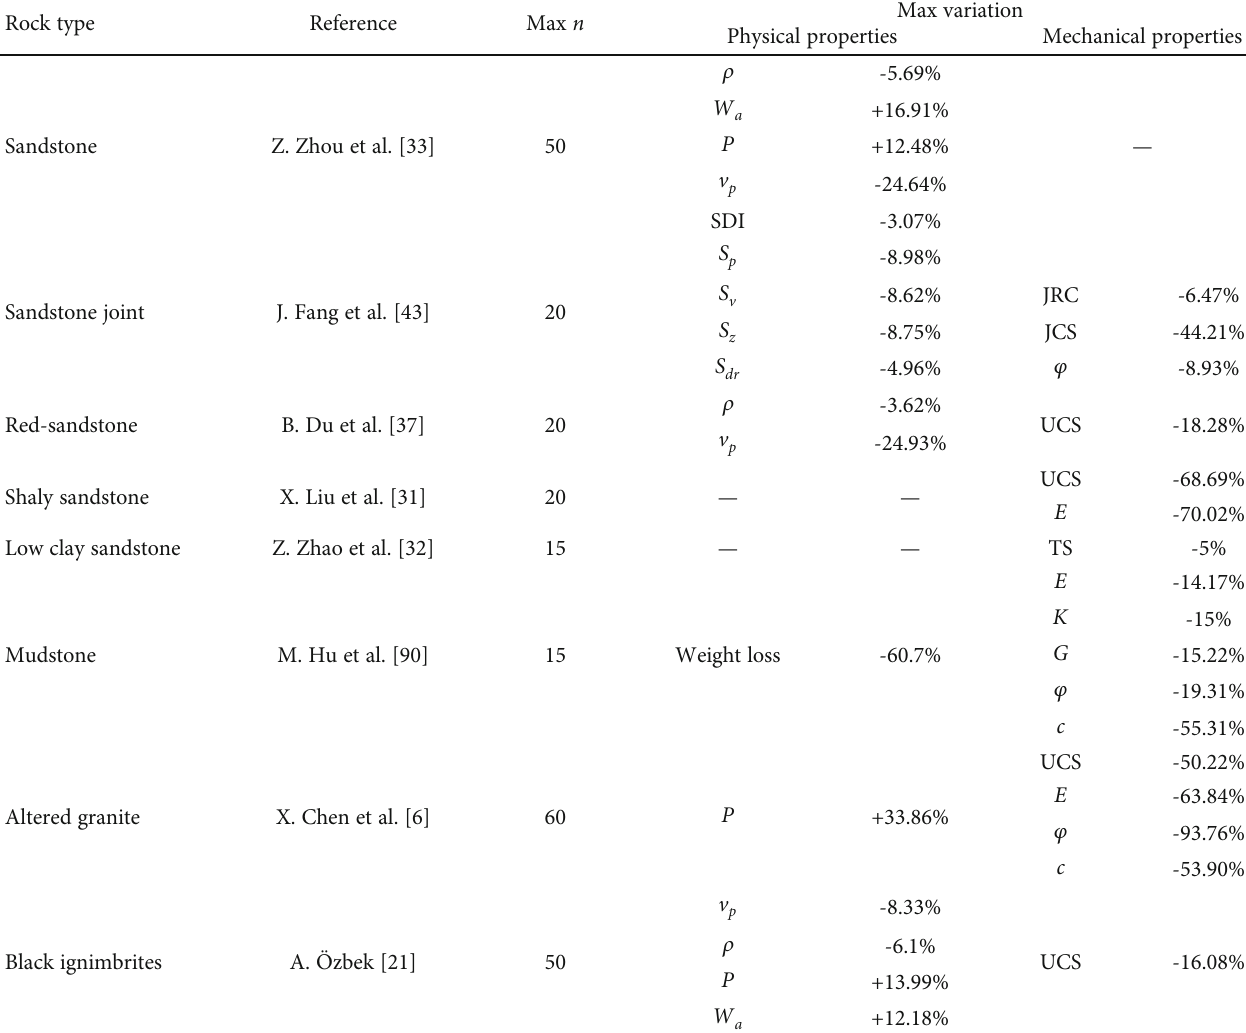
Table 2: Deterioration of di ff erent rocks after cyclic dry-wet